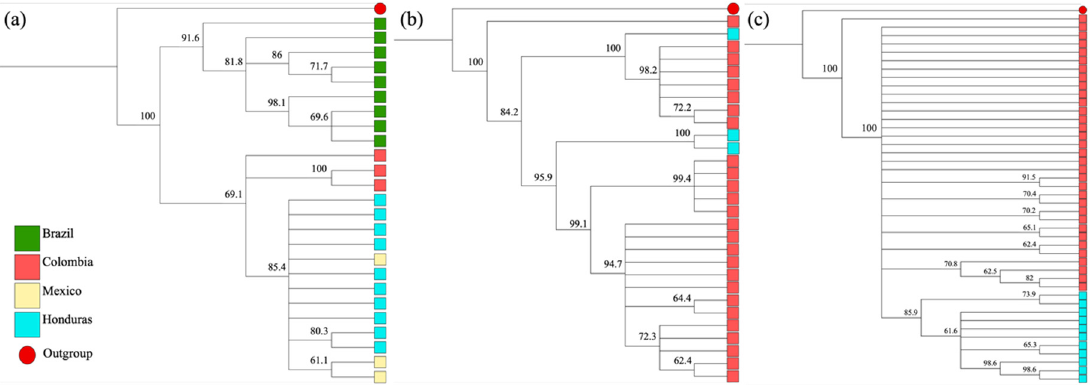
Figure 4. Dendrograms constructed using the neighbour-joining method and Geneious 9.1.7 software with a bootstrap of 1000 replicates: ( a ) Anopheles argyritarsis ; ( b ) An. apicimacula ; ( c ) An. neomaculipalpus.